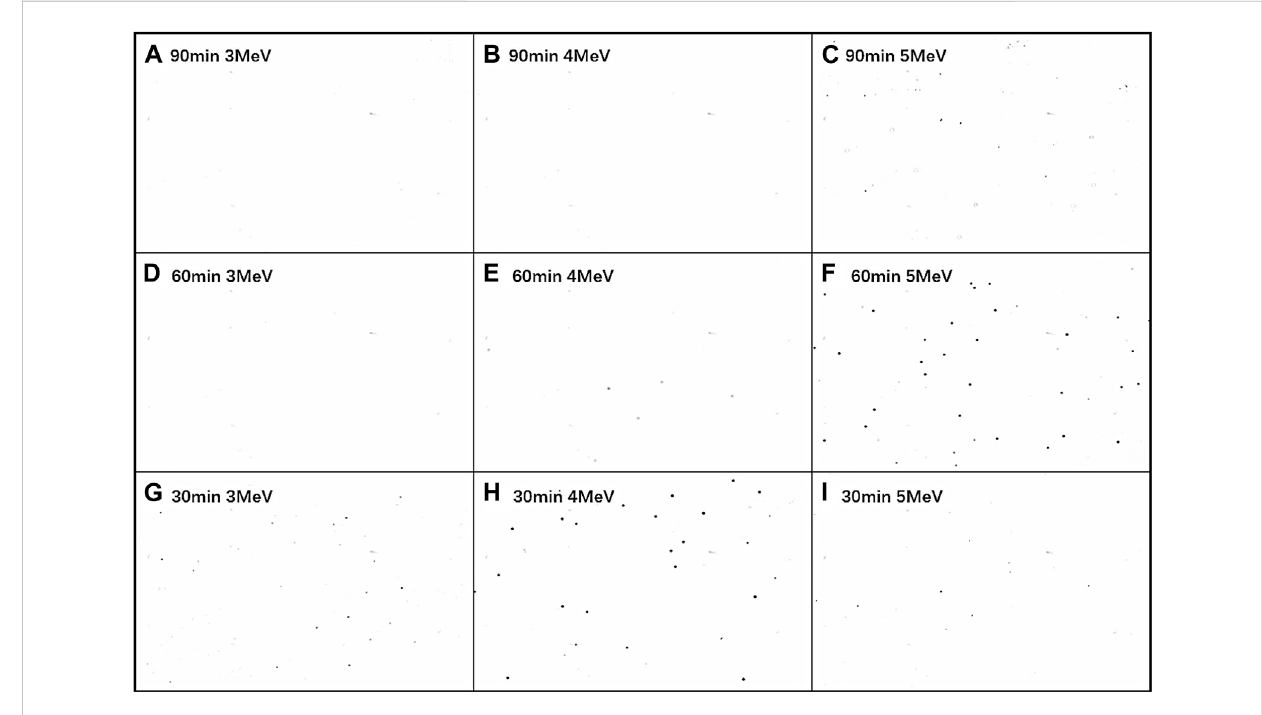
FIGURE 3 Etched CR-39 surfaces after irradiation with (A) , (D) , (G) 3.00 MeV; (B) , (E) , (H) 4.00 MeV; (C) , (F) , (I) 5.00 MeV covered with 5- μ m aluminum foil in different etching